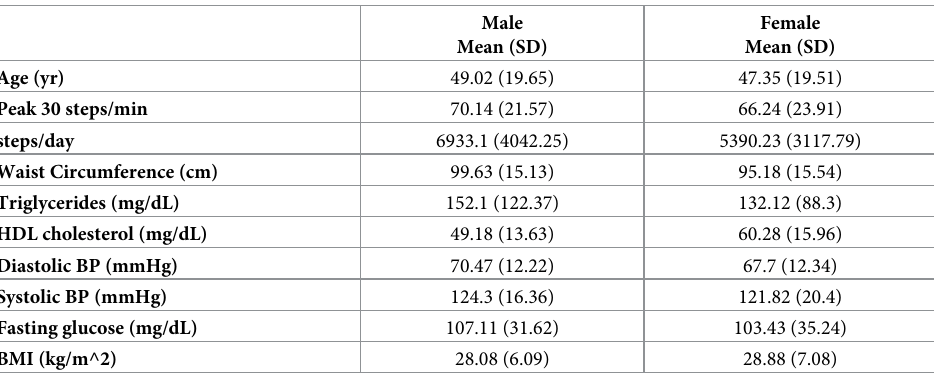
Table 2. Subject characteristics of NHANES data after processing.